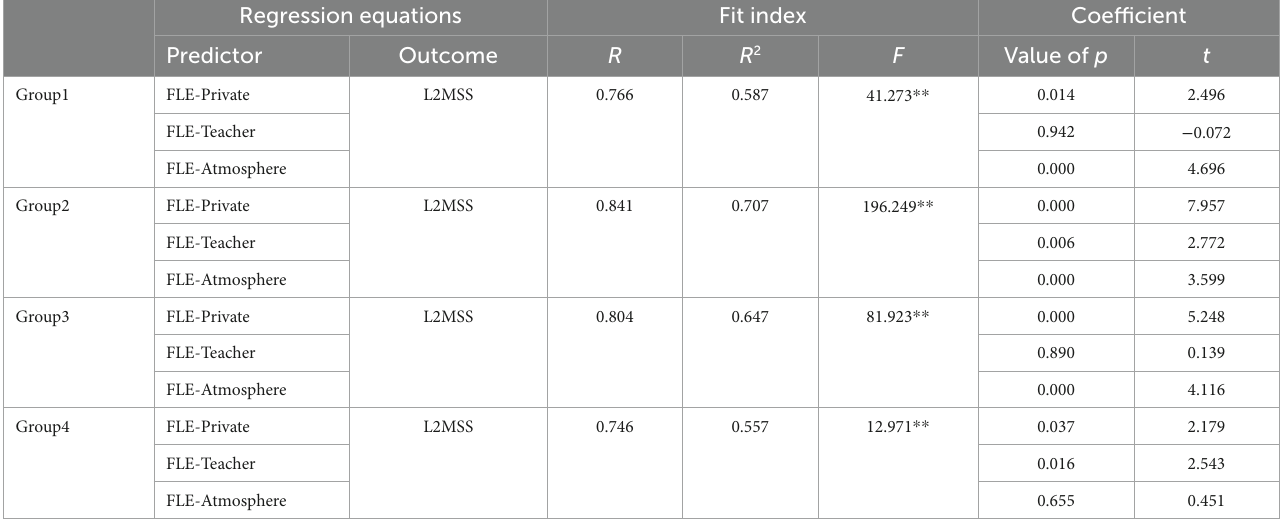
TABLE 3 Multiple regression analysis on FLE and L2 motivation at different proficiency